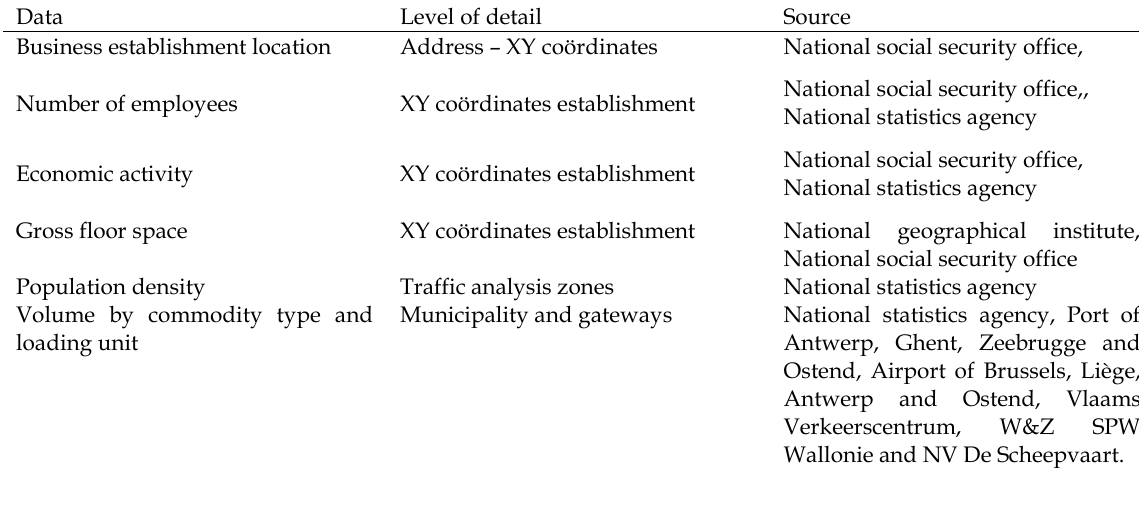
Table 1. Data overview for freight generation